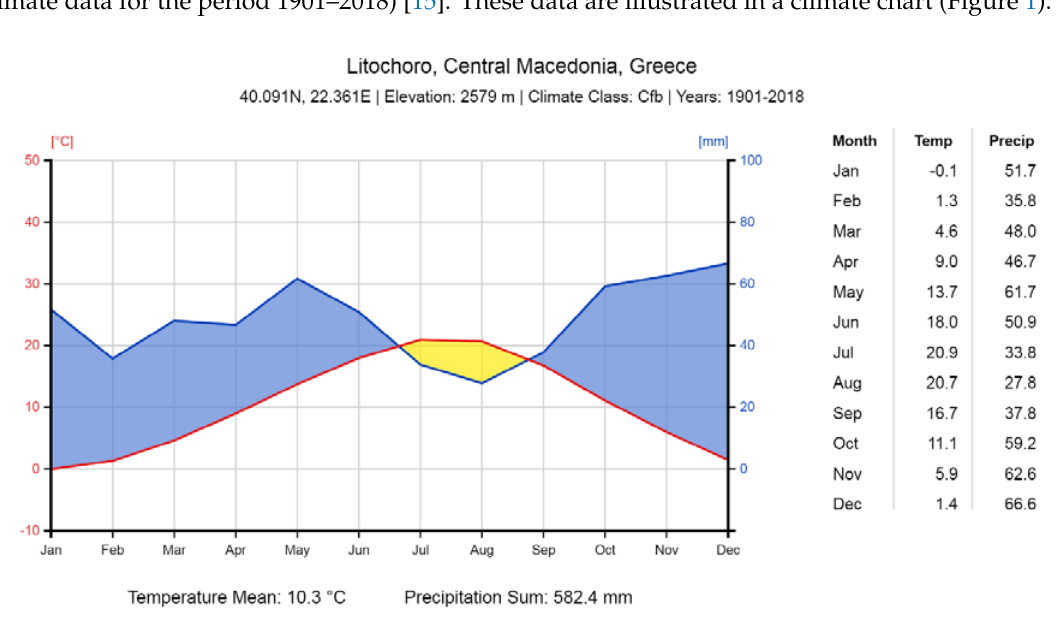
Figure 1. Ombrothermic diagram of Litochoro [15].